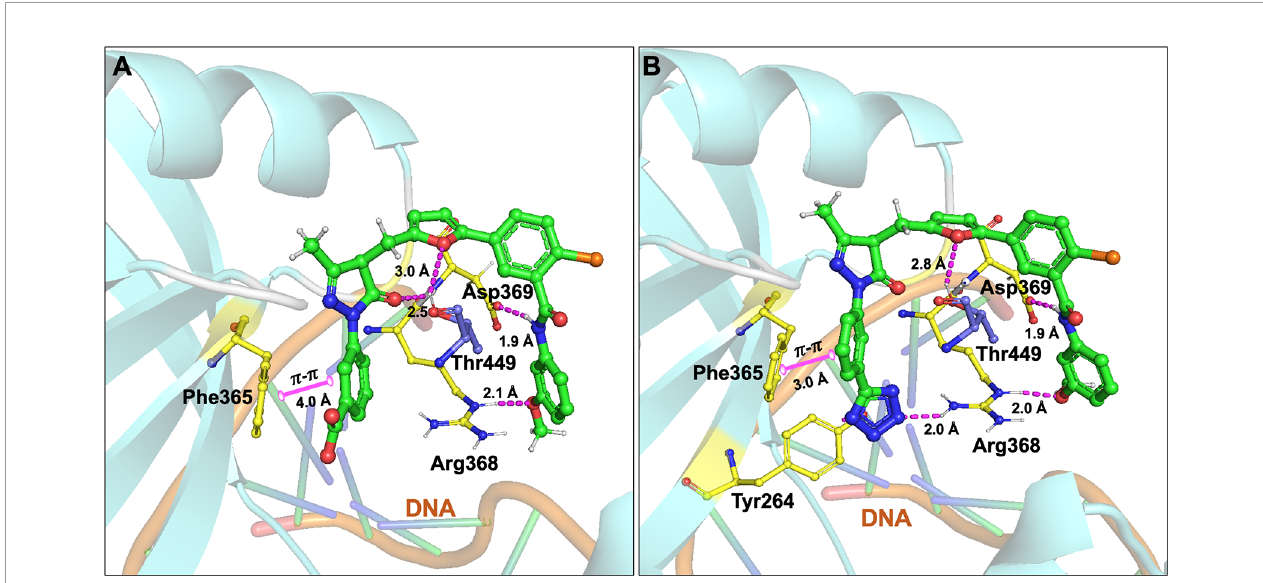
FIGURE 4 | Molecular interactions of (A) compound 149 and (B) 245 (all in green carbon) with Ku70/80 heterodimer (key amino acids are shown in yellow carbon (Ku70), blue carbon (Ku80) and cartoon is shown in cyan color). Interaction with amino acid side chains is indicated with the dashed magenta lines and p – p stacking interactions are shown in solid magenta dumbbell. The DNA helical structure is depicted in greenish blue sticks and light orange cartoon. Interaction distances indicated in Å.